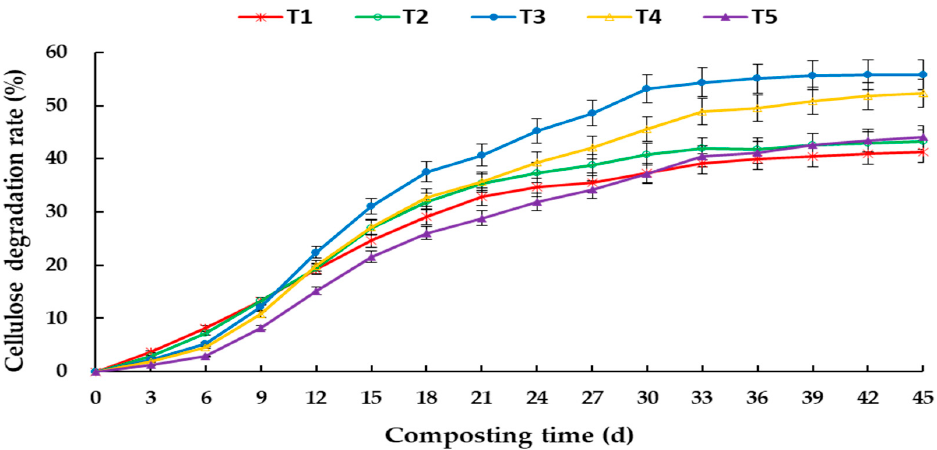
Figure 3. Changes in cellulose degradation rate during composting of corn straw and cow dung under different C/N ratios.